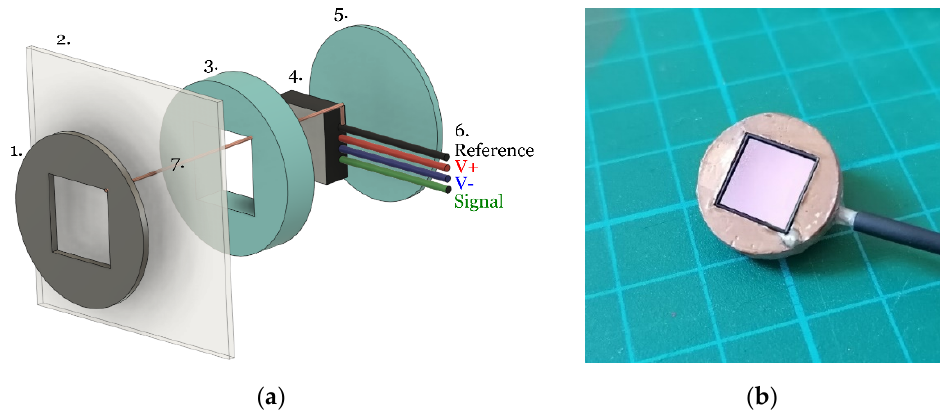
Figure 3. ( a ) Exploded view of sensor: (1) deposited reference electrode material (conductive polymer ink or conductive textile fabric), (2) cotton substrate, (3) and (5) 3D printed housing, (4) EPS ASIC, (6) power and signal connections, (7) single strand copper connection to the sensor ground. ( b ) assembled EPS sensor, with stAandard copper electrode, without the cotton layer attachment.